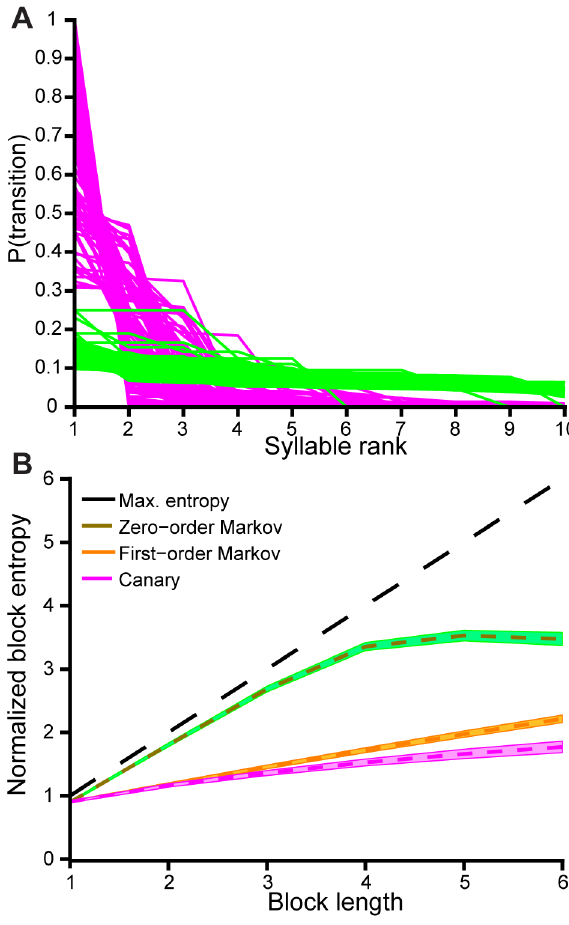
Figure 4. Canary phrase sequences are more ordered than a first-order Markov process. A, For each phrase type the magnitudes of transition probabilities to the next phrase are shown sorted by probability. The rapid decay of the traces indicates that most syllables are followed by just a few high probability transitions. Canaries (magenta) do not simply emit phrases at random, as in the zero-order Markov case (green). B, Block entropy is the entropy computed for sequences of n phrases, i.e. the block size (see Materials and Methods ). The block entropy was computed for the actual phrase labels (canary), a randomization that only preserved phrase occurrence probabilities (zero-order Markov), and a randomization that only preserved nearest-neighbor transition probabilities (first-order Markov). Block entropy grows slowly with block size (n) for canary song, relative to the random models. This slower entropy growth hints at the existence of structure beyond a first-order Markov chain in phrase types.